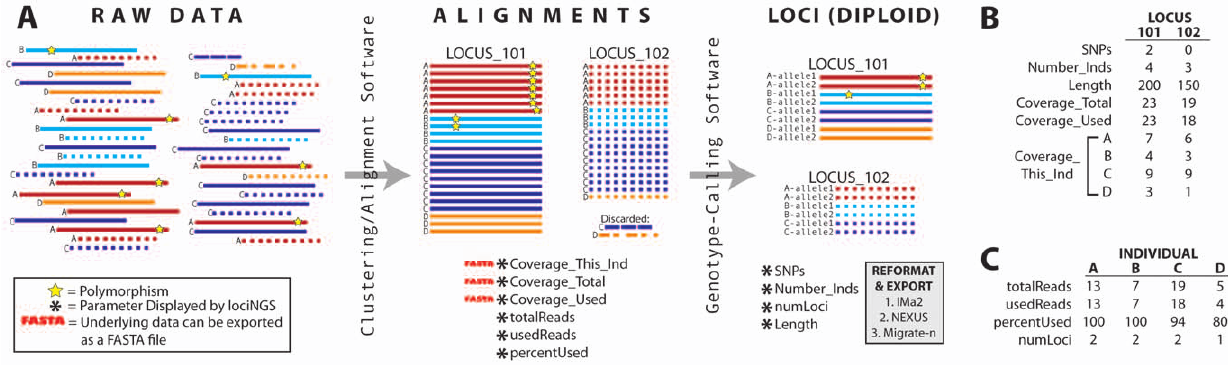
Figure 2. How the data are generated, where the parameters come from and example data. ( A ) Letters represent individuals and lines represent sequences; there are four individuals and two loci. Raw data from the sequencer is put through an alignment or clustering program to collect reads into alignments. From each alignment file, LOCI NGS reports totalReads, usedReads, percent reads used (percentUsed), Cover- age_This_Ind, Coverage_Total and Coverage_Used; LOCI NGS will also export the data underlying the coverage parameters in FASTA format. Genotype- calling software will reduce sequence reads to loci (phased alleles). LOCI NGS uses these loci to report SNPs, Number_Inds, numLoci and Length; the program can reformat the loci into IMa2, NEXUS or Migrate formats. For further explanation of the parameters, see Table 1. ( B ) The parameter values for the two loci (LOCUS_101 and LOCUS_102) in this example. ( C ) The parameter values for the four individuals (A,B,C,D) in this example.